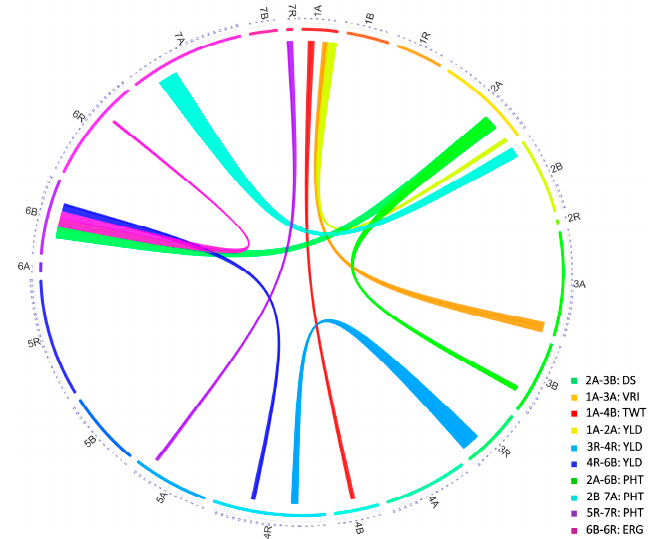
Figure 8. Epistasis QTL network. Circular plot represents the hexaploid triticale genome arranged in chromosomes (chrs) 1–21 (1A-7R) in clockwise direction in Circos diagram. Numbers on colored outer circle represents cM on respective chrs. Colored connections represent epistasis loci (QTL) controlling different traits (DS, VRI, TWT, YLD, PHT, ERG) and the widths of connections on respective chrs represent QTL intervals.